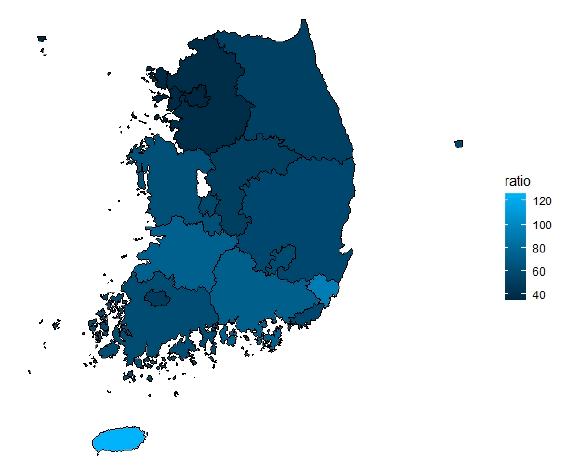
Figure 3. Weighted number of discharged pneumonia patients by regional population in South Korea (2017) (unit: per 10,000 person).